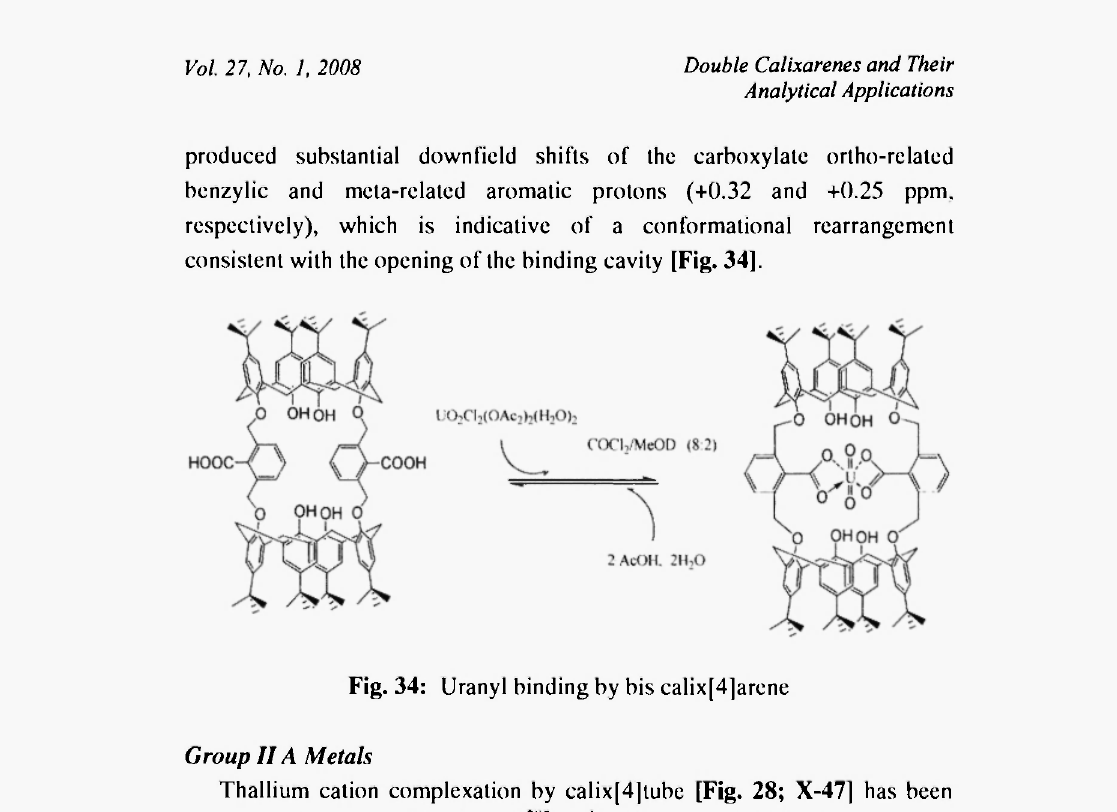
Fig. 34: Uranyl binding by bis